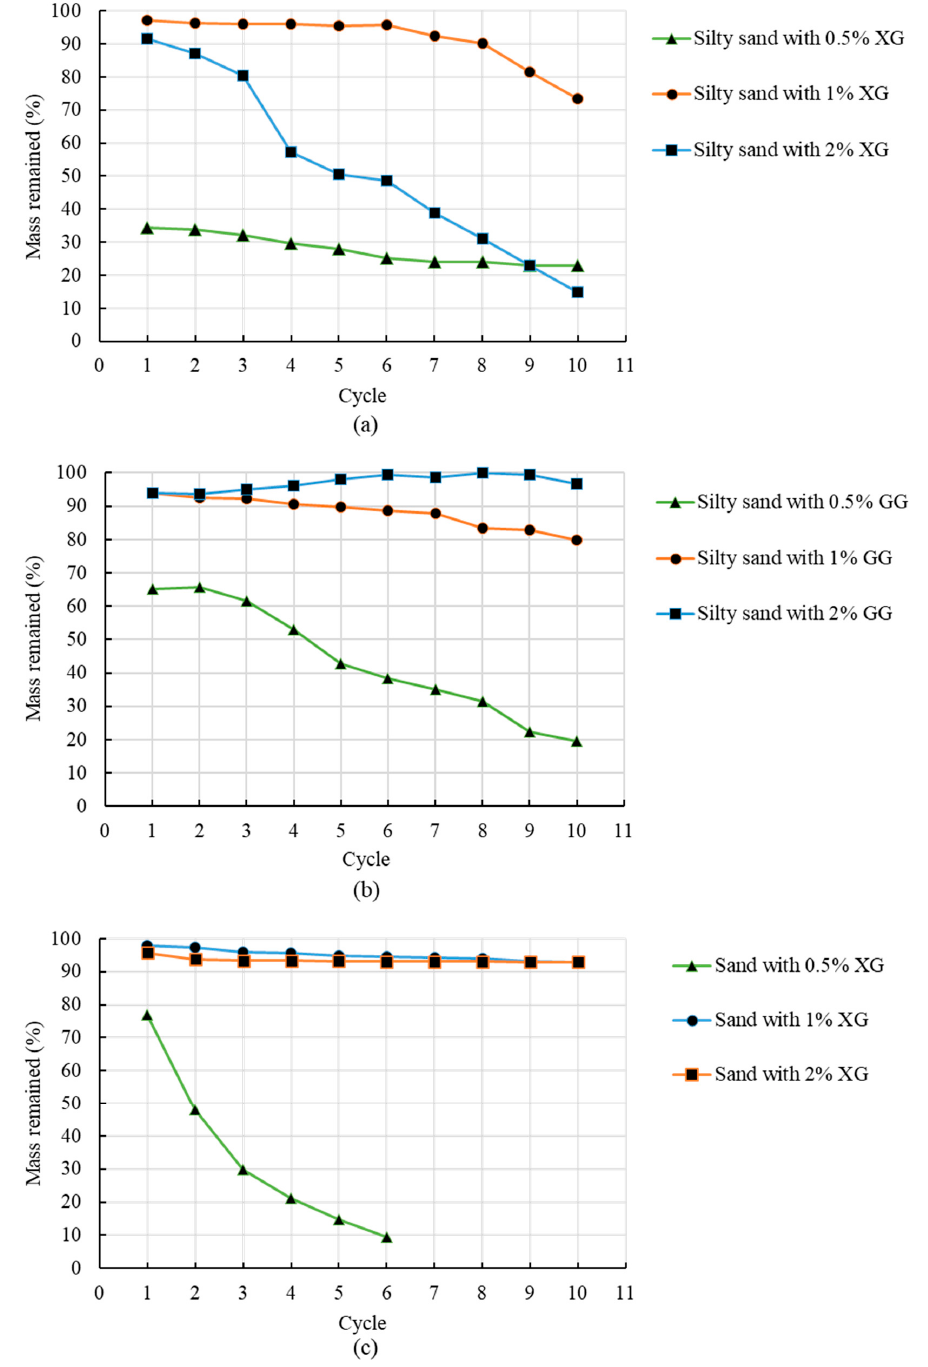
Figure 4. Change in mass for ( a ) Silty sand—XG, ( b ) Silty sand—GG, ( c ) Clean sand—XG.